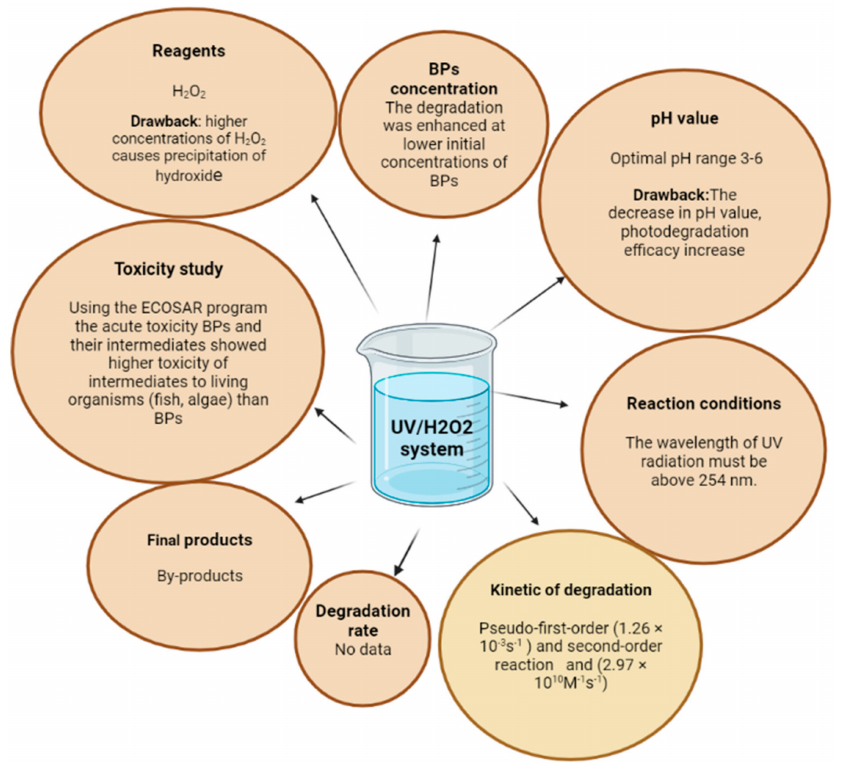
Figure 3. An overview of the effect of different conditions in the UV/H 2 O 2 system on the degradation process of BPs. Created in